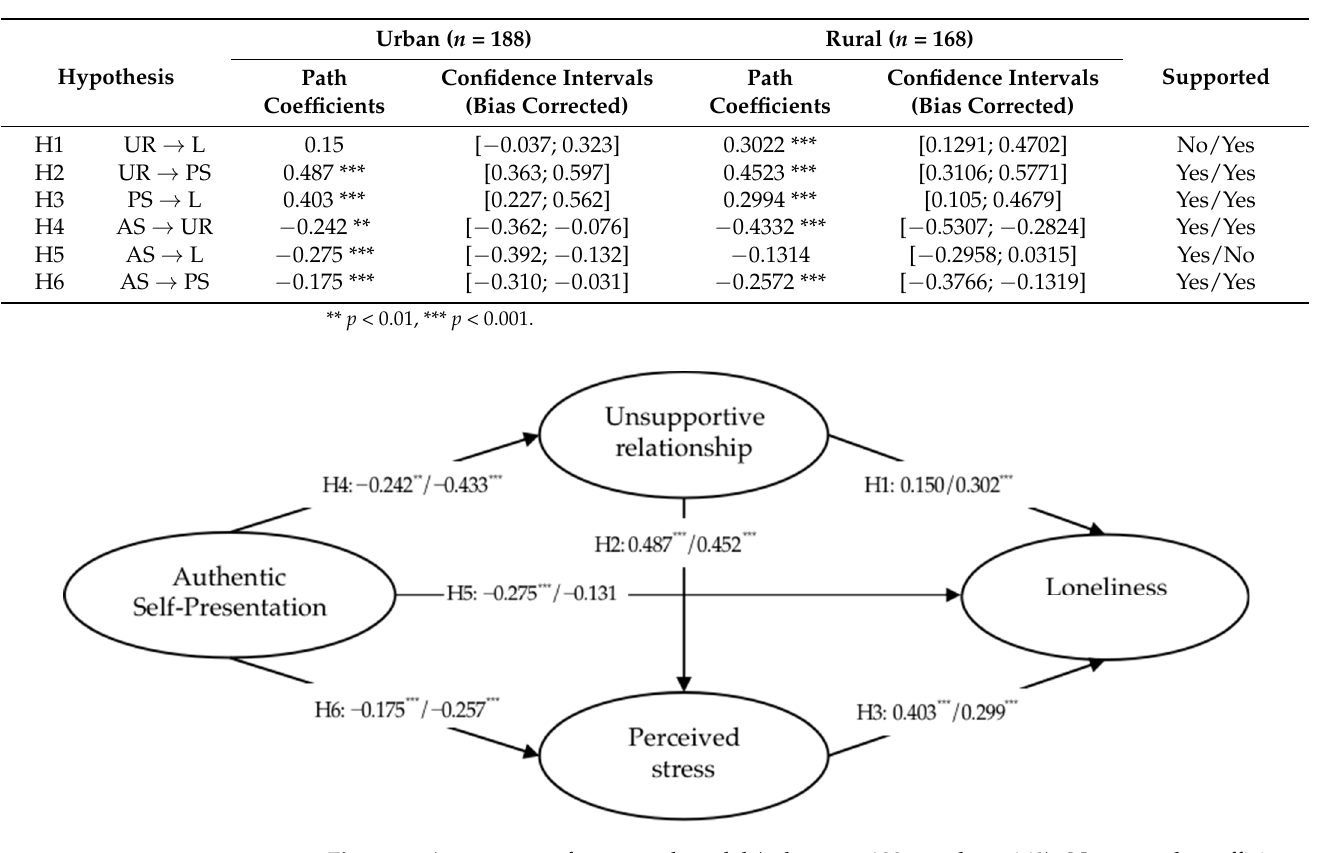
Table 4. Assessment of structural model.